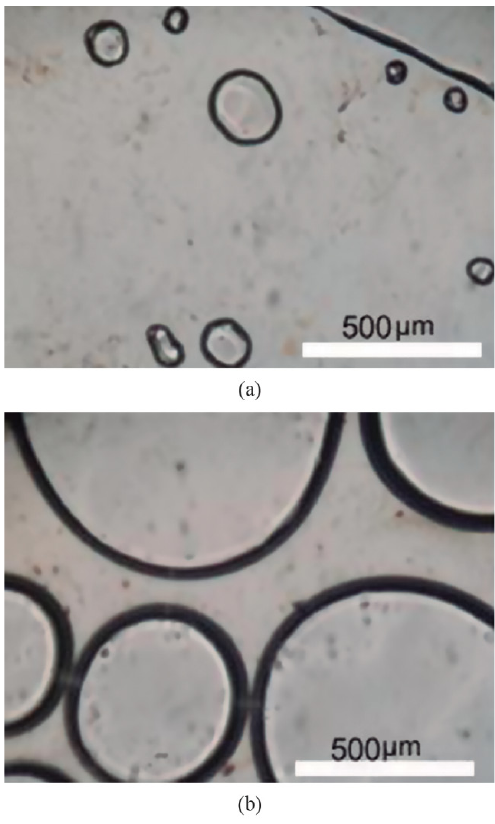
Figure 2. OM images of PET/PC (80/20 wt/wt%) (unexposed): a) 25°C; b) 280 °C.